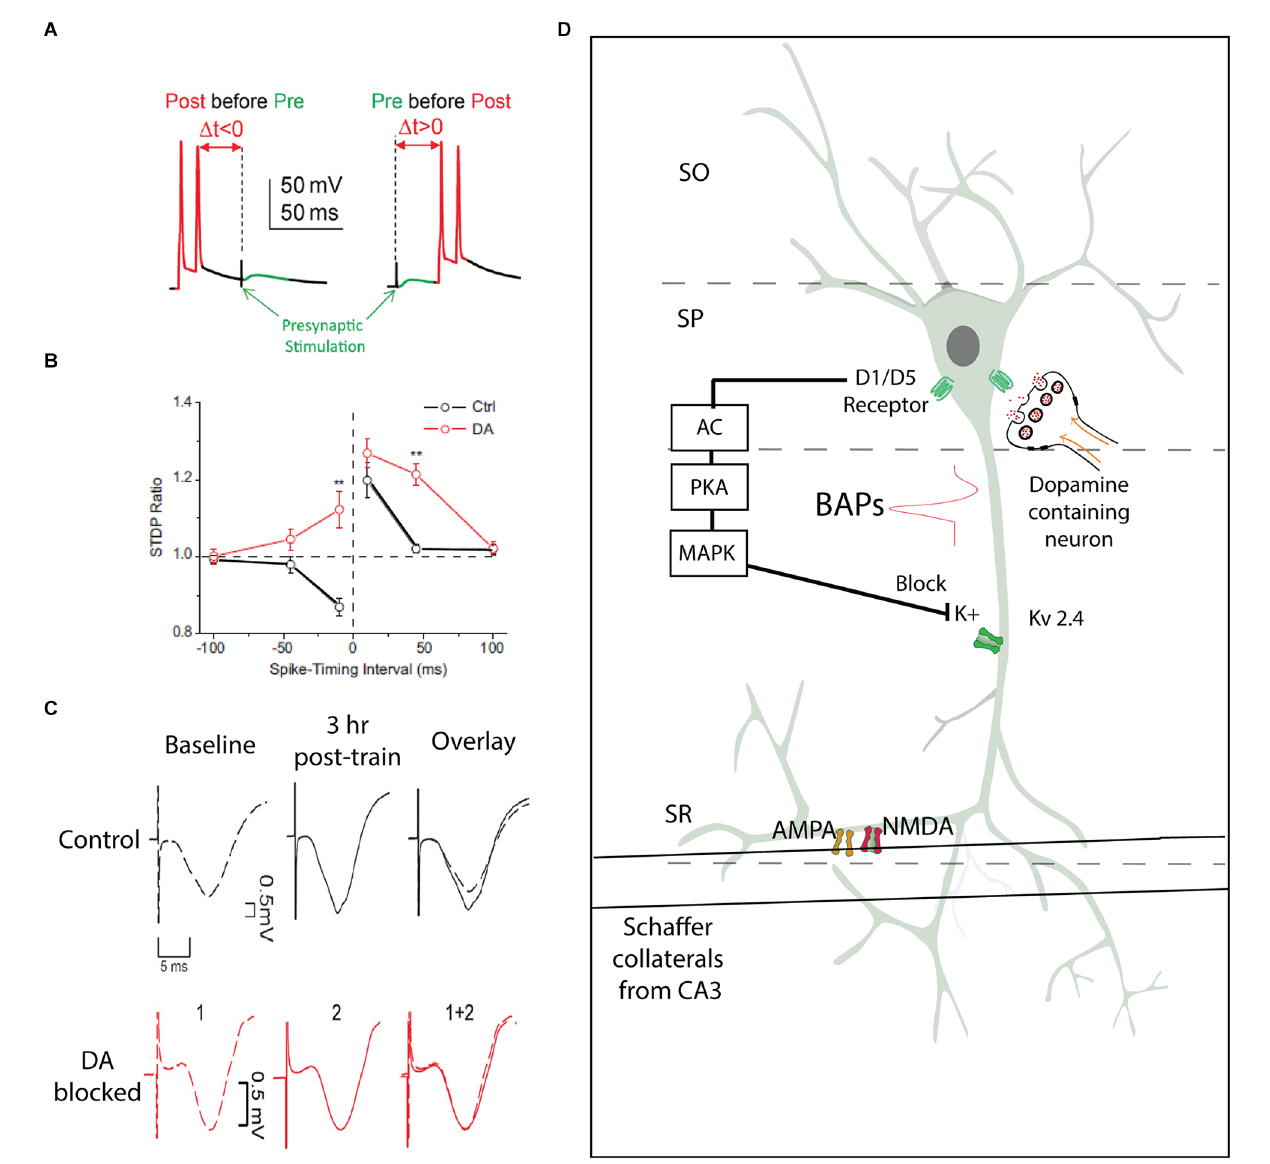
FIGURE2 Spike timing dependent plasticity as a model for synaptic plasticity underlying hippocampal learning. (A) Experimental protocol from patch clamp experiments in cell-attached mode, two action potential produced on the recorded cell following by a presynaptic stimulation, or presynaptic stimulation preceding action potentials (adapted from Yang and Dani, 2014). (B) Illustration from Zhang et al. (2009) with black lines demonstrating responses of pyramidal neurons showing a characteristic STDP response, and the addition of extracellular dopamine broadening the temporal window and